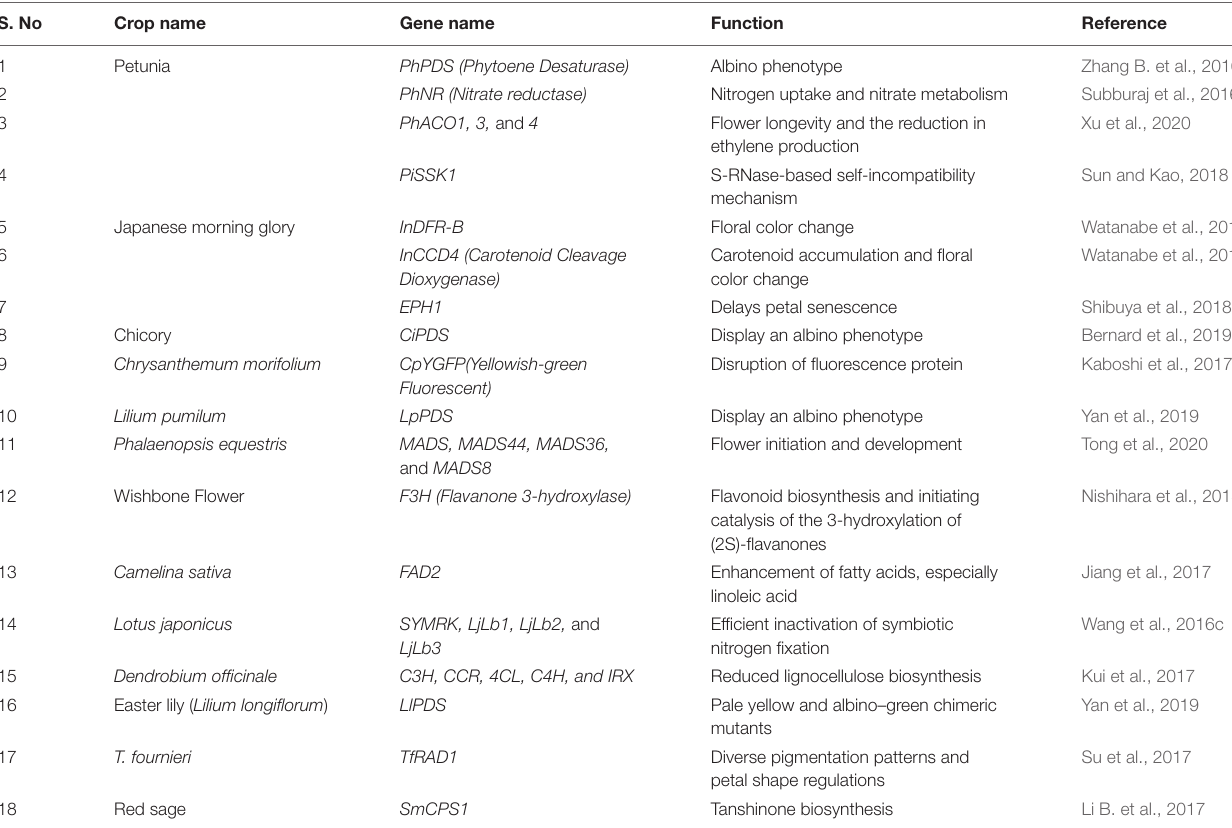
TABLE 2 | Partial list of genes of ornamental plants and its specific functions modified via CRISPR/Cas9 system. S.